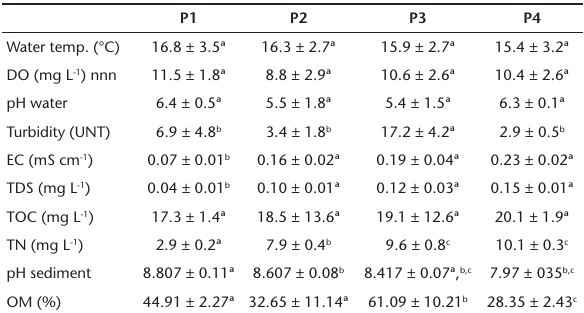
Table 1. Mean and standard deviation of abiotic variables in four stretches of the River Tigre, Erechim, Rio Grande do Sul.